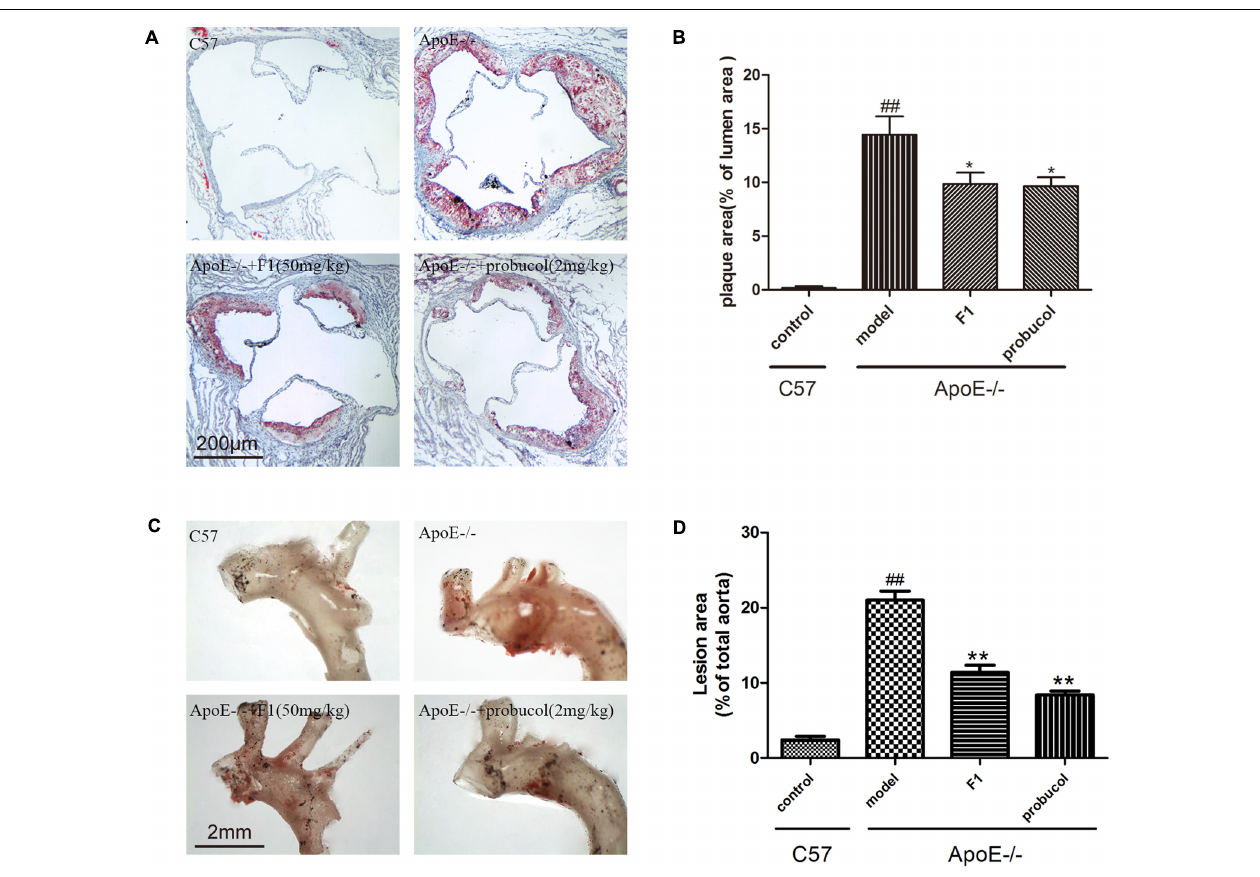
FIGURE 1 | Ginsenoside F1 reduced atherosclerotic plaque development in ApoE − / − mice. All mice were fed HFD. ApoE − / − mice were treated with GF1 (50 mg/kg/day, i.g.), probucol (2 mg/kg, i.g.), or its vehicle (as model group) for 8 weeks; C57 mice were used as the control group. (A) Representative light photomicrographs of oil red O-stained sections from the aortic root. (B) Statistical analysis of the oil red O-stained sections. (C) Representative images of Sudan IV-stained en face of the proximal aorta. (D) Statistical analysis of aortic AS expressed as a fraction of the total aortic area. Values ( n = 10 per group) are expressed as the mean ± SD. Values ( n = 10 per group) are expressed as the mean ± SD. ## p < 0.01, vs. C57 control group; ∗ p < 0.05, ∗∗ p < 0.01 vs. the vehicle-treated ApoE − / − model group.